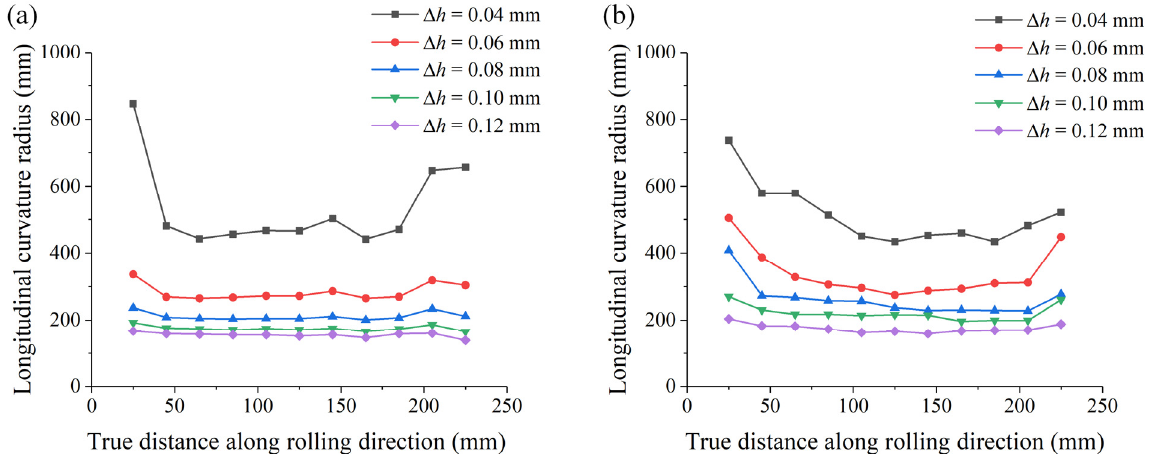
Figure 14. Longitudinal curvature radius of the formed spherical parts: ( a ) simulative parts; ( b ) experimental parts.